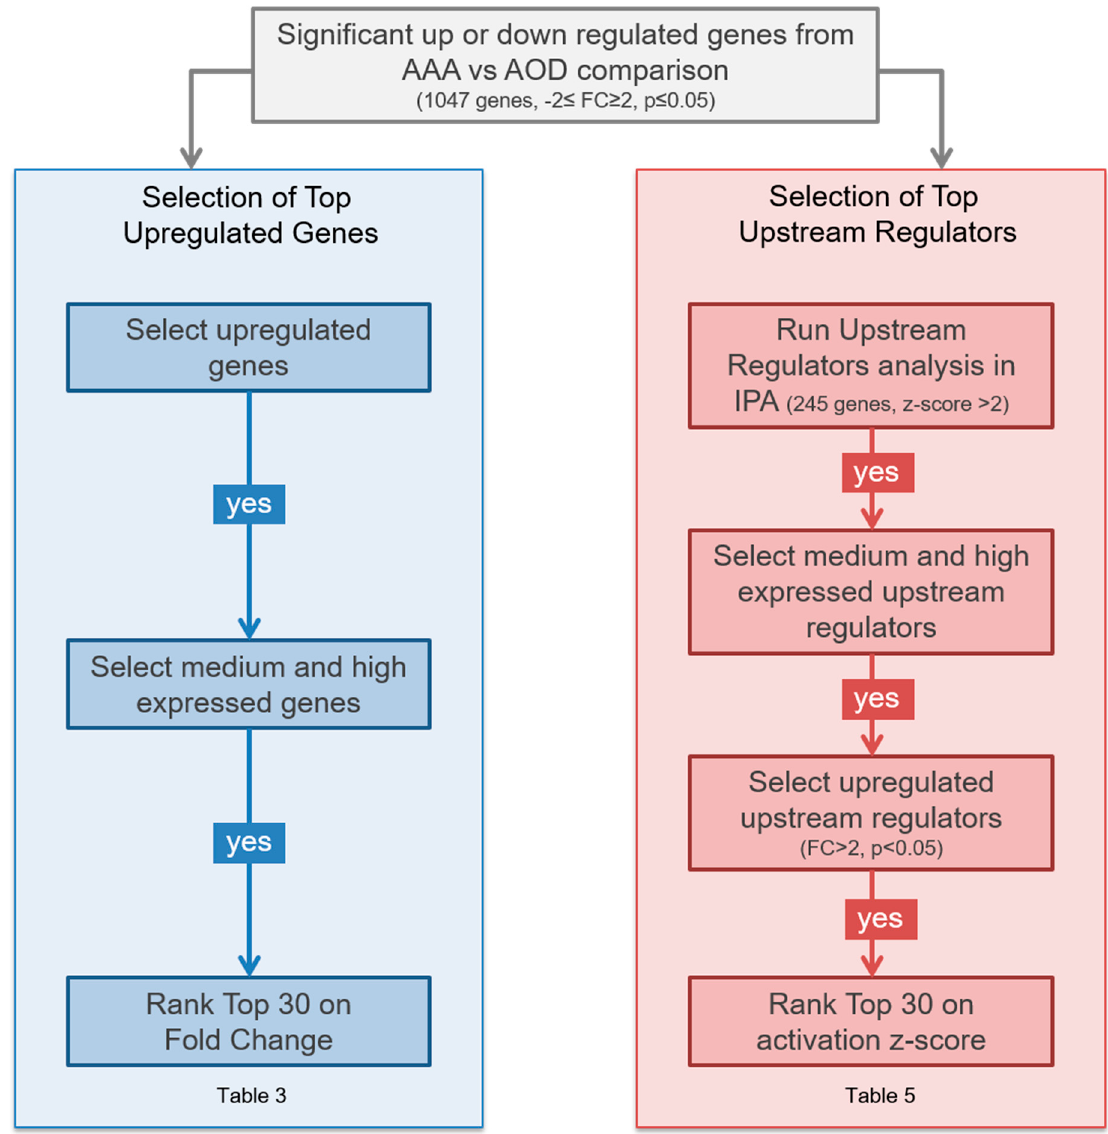
Figure 2. Selection procedure flowchart of the top upregulated genes (left) and top upstream regulators (right).